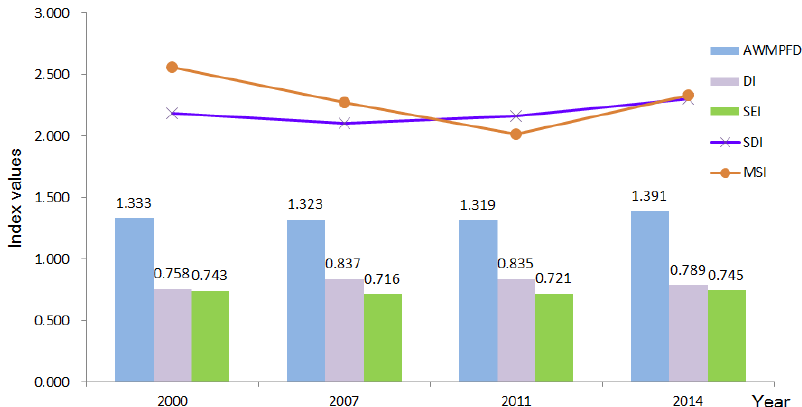
Figure 8. The changes in the landscape pattern index in the HRB from 2011 to 2014.